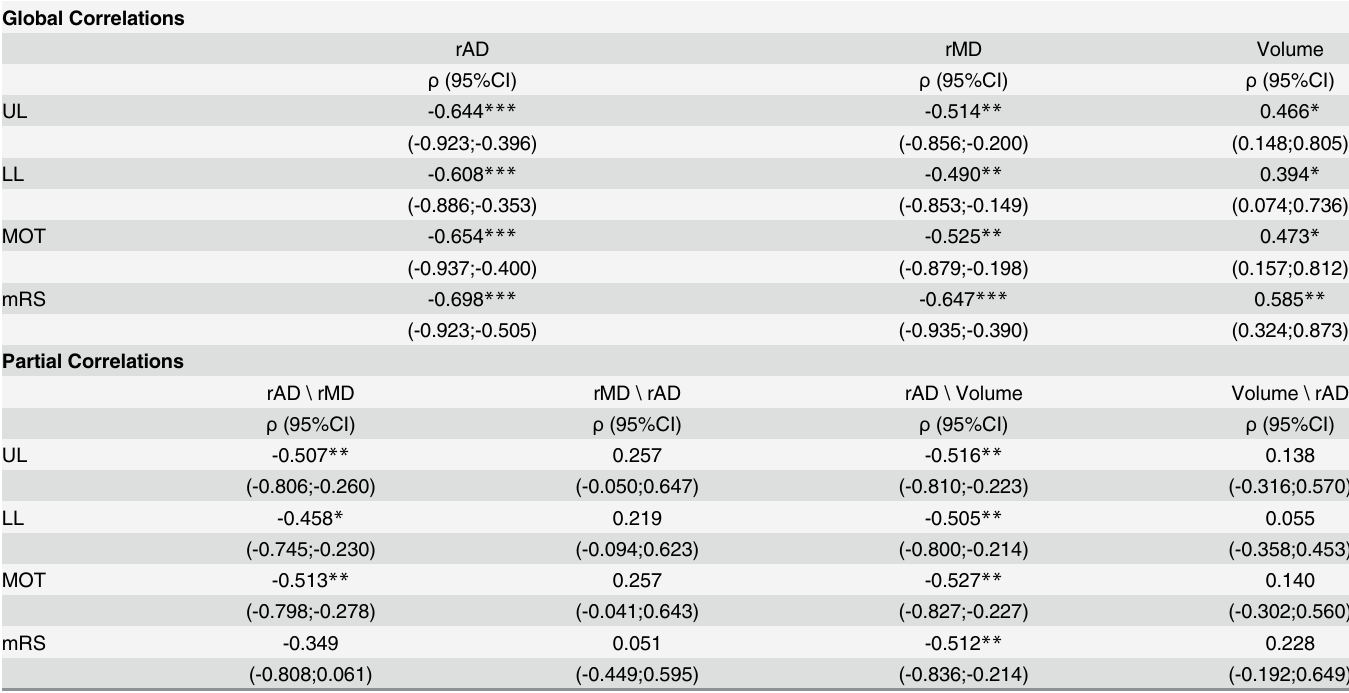
Table 3. Global and partial correlations between diffusion metrics of the corona radiata, infarct volume, and outcome. Global Correlations